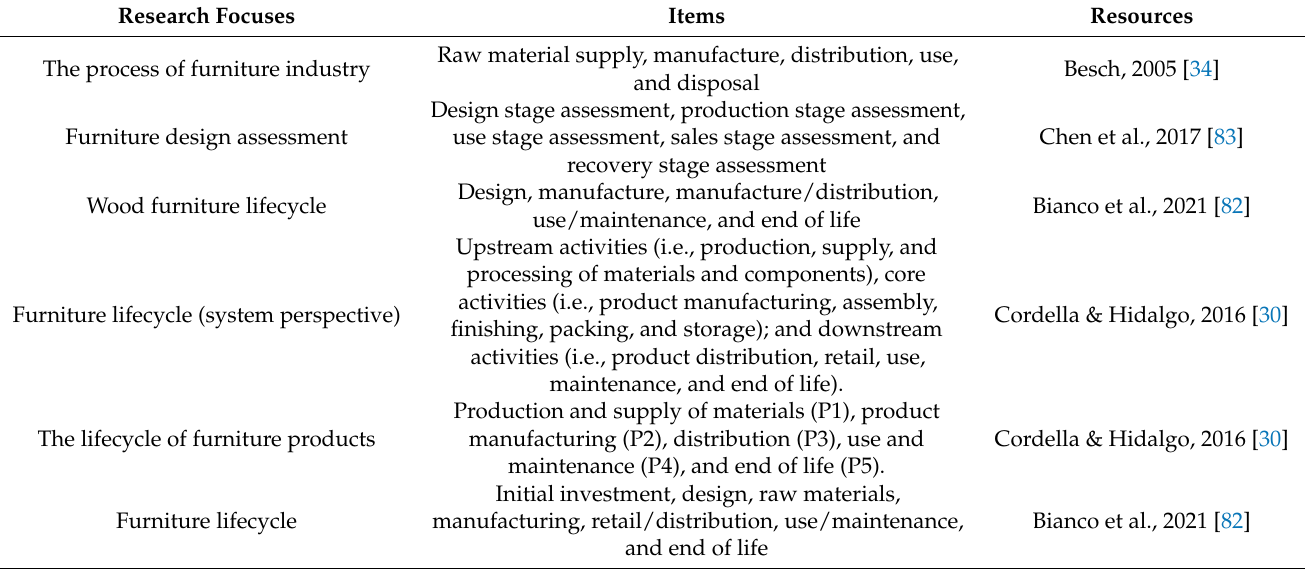
Table 2. Previous research related to the definition of furniture lifecycle stages (generated by